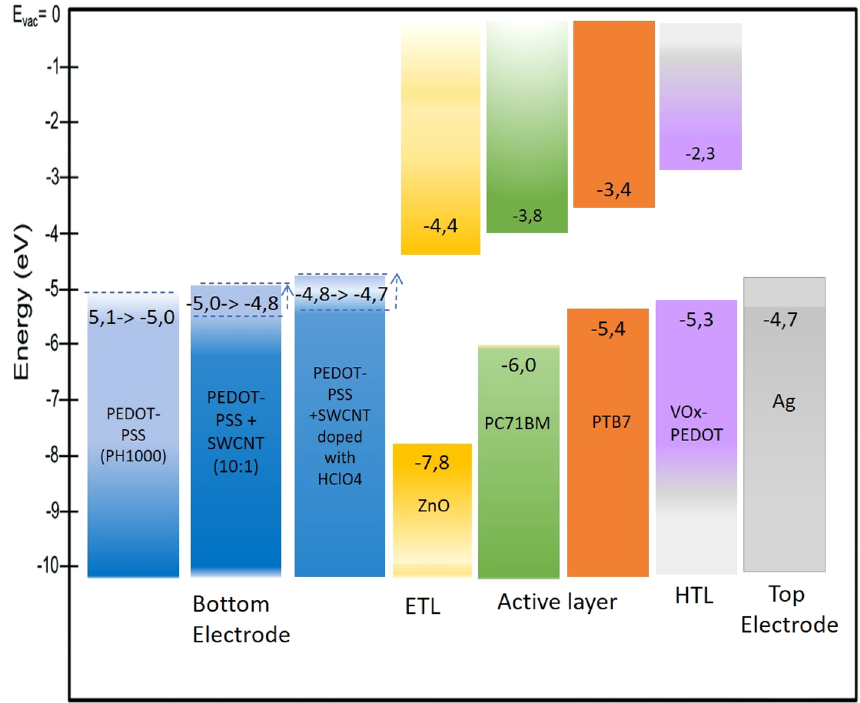
Figure 10. Energy level diagram for PSCs and electrical contacts for the TCF(PEDOT-PSS(PH1000), PEDOT- PSS + SWCNTs and PEDOT-PSS + SWCNTs + HCLO 4 ), HTL and HOMO–LUMO of the donor polymers (PTB7) and PC 71